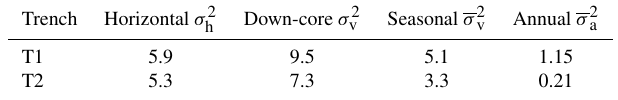
Table 1. Variance levels of the two trenches: the horizontal variance is the mean variance of all depth layers on absolute coordinates; the down-core variance is the mean vertical variance of all respective trench profiles. The seasonal as well as the annual variance levels denote the variances of the respective mean seasonal and annual δ 18 O time series of the two trenches (Fig. 5). All numbers are in units of (‰) 2 .